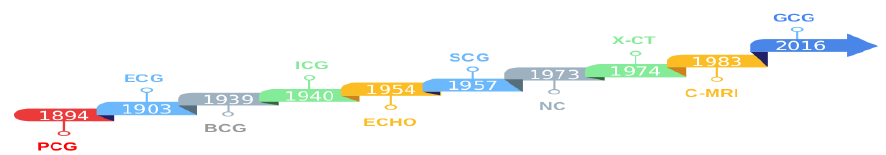
Figure 1. Timeline evolution of existing techniques for monitoring cardiac